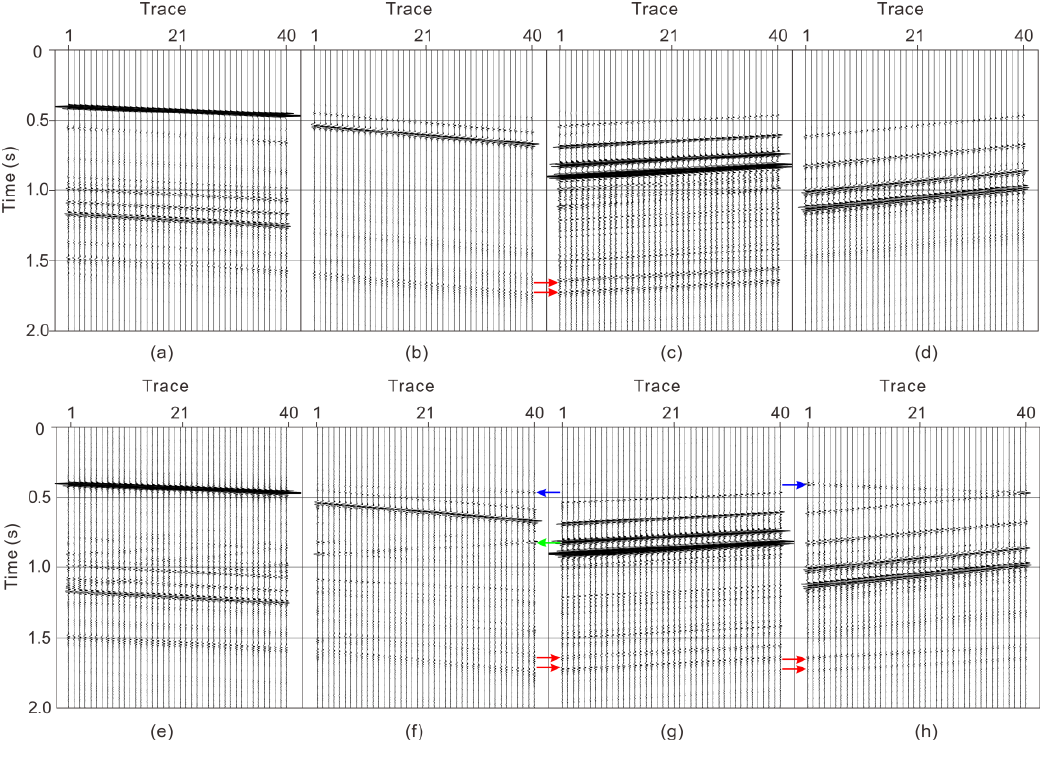
Figure 12. Results for the separation of the VSP wavefield. ( a , e ) Downgoing P-wave; ( b , f ) Downgoing S-wave; ( c , g ) Upgoing P-wave; ( d , h ) Upgoing S-wave; ( a – d ) Results for our method; ( e – h ) Results for the high-resolution Radon transform method.